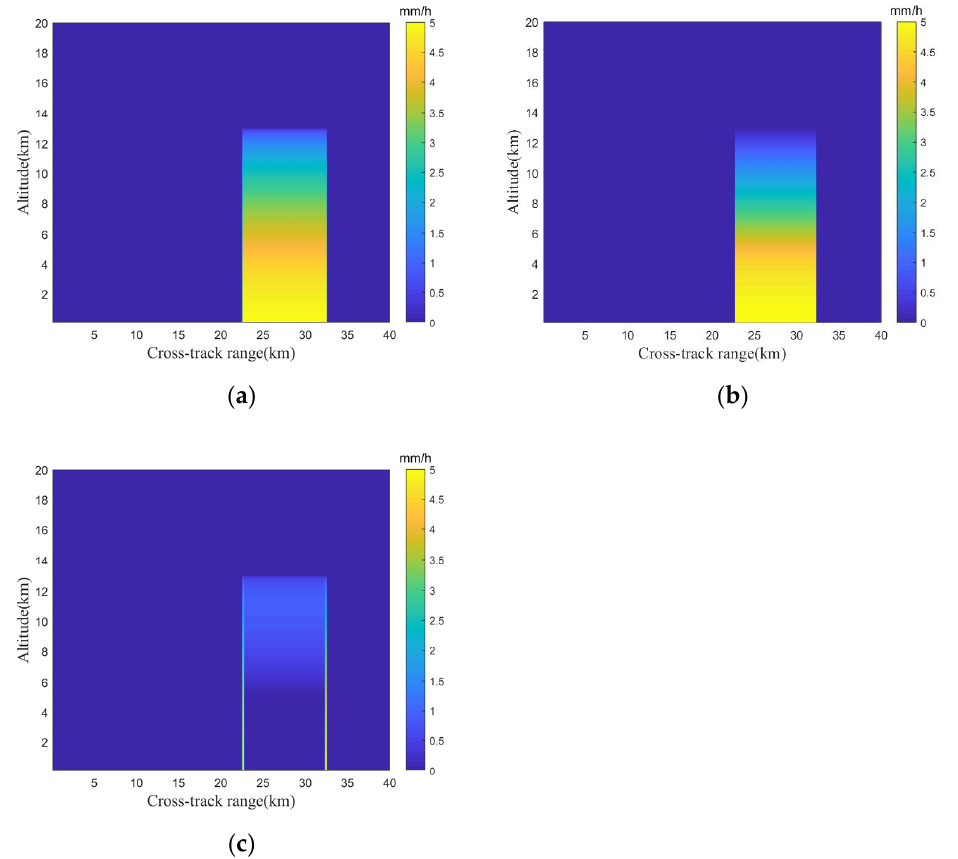
Figure 9. Two-dimensional distribution of rectangular rain. ( a ) The given two-dimensional distri- bution of rain; ( b ) the two-dimensional distribution of rain retrieved by MRA; and ( c ) the absolute error diagram.